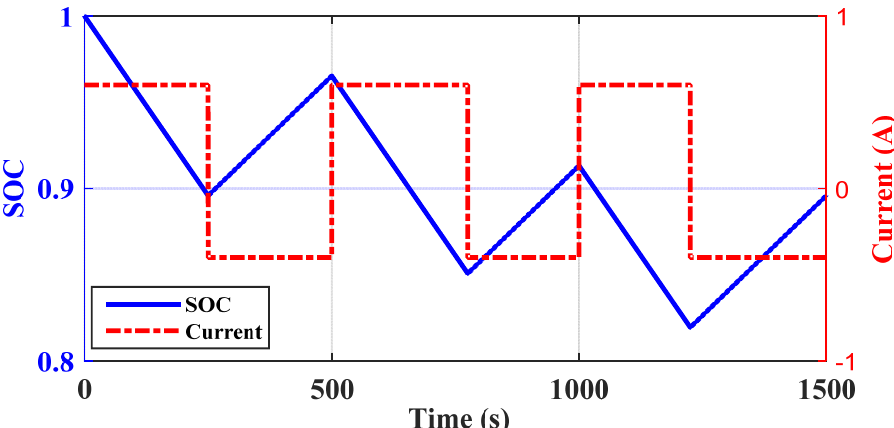
Figure 11. Change in SOC considering limitation in high power charging.